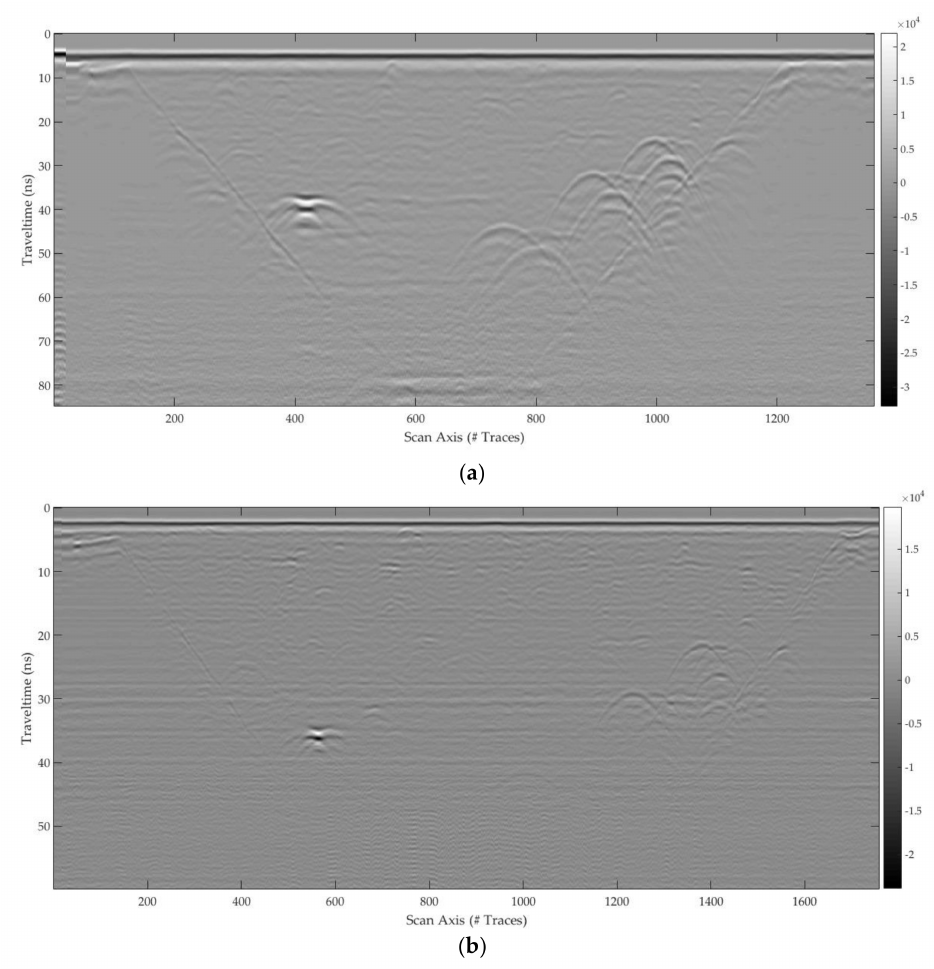
Figure 23. Profiles recorded in the limestone region by using GPR 1, on acquisition line 1, with antennas operating at: ( a ) 400 MHz; ( b ) 900